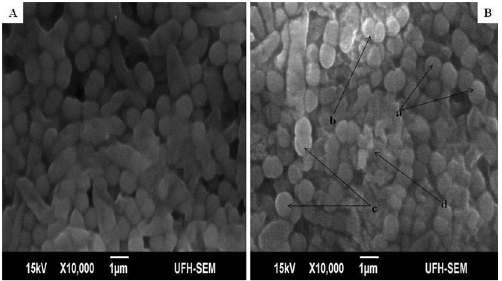
Fig. 5. Influence of ethanol extract on the morphology of S. aureus . A = Extract untreated S. aureus ; B = Extract treated S. aureus . (a = intact but affected cells; b = dead cells with destroyed cells; c = swollen cells; d = shredded